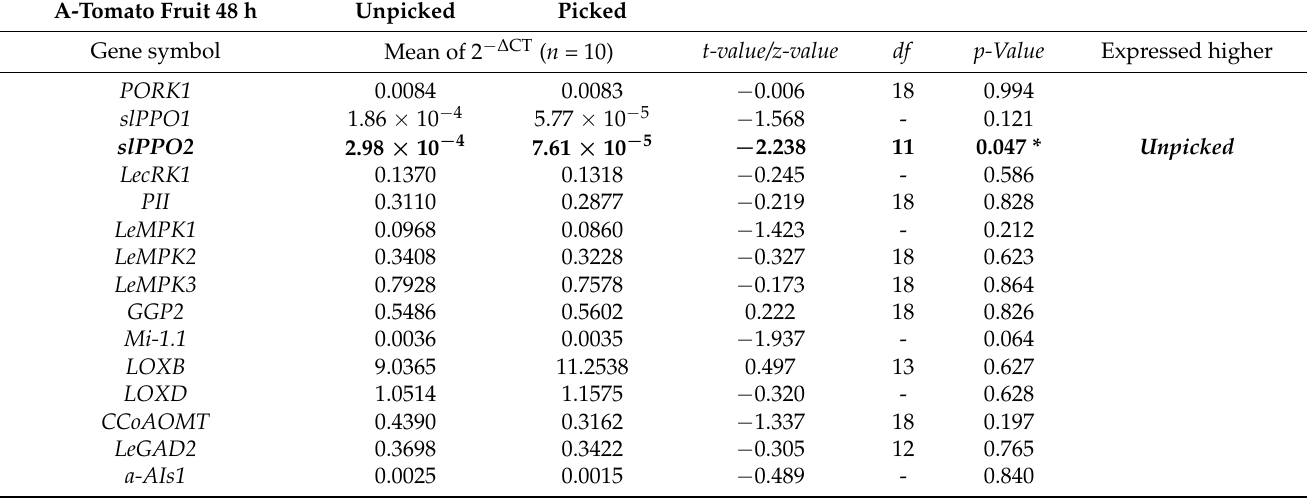
Table 4. The statistical analysis results of differential gene expression in unpicked and picked colour- break Roma tomato fruit inoculated with Bactrocera tryoni larvae and dissected at 48 h and 120 h after inoculation. The comparative analyses were performed between the following: (A) gene expression from infested tomato tissue sampled from unpicked versus picked tomato fruit 48 h after larval inoculation; (B) gene expression from infested tomato tissue sampled from unpicked versus picked tomato fruit 120 h after larval inoculation; (C) gene expression from infested tomato tissue sampled from unpicked tomato fruit 48 h versus 120 h after larval inoculation; and (D) gene expression from infested tomato tissue sampled from picked tomato fruit 48 h versus 120 h after larval inoculation. Analyses were unpaired t -test or Mann–Whitney U test, depending on the error distribution of the data. The 15 selected genes are putatively associated with plant-induced defence response and are as follows: (1) plant perception, such as receptor-like kinase pathway ( PORK1 and LecRK1 ); (2) signalling transduction, such as D-mannose/L-galactose pathway ( GGP2 ), mitogen-activated protein kinase pathway ( LeMPK1, LeMPK2 and LeMPK3 ), lipoxygenase ( LOXB and LOXD ); (3) GABA signalling pathway ( LeGAD2 ); (4) genes with anti-nutritional activity ( SlPPO1-2, PII and a-AIs1 ); (5) CoA O-methyltransferase ( CCoAOMT ); (6) tomato resistance R gene ( Mi-1.1 ). *: p <